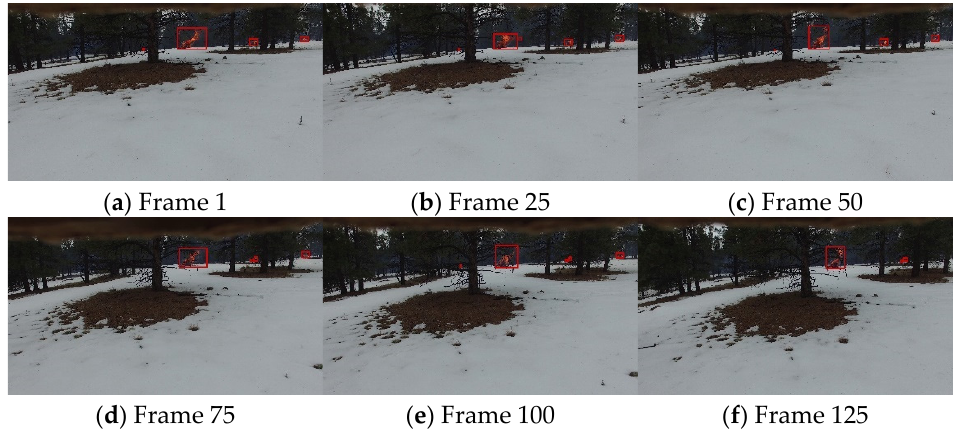
Figure 1. Schematic diagram of forest fi re detection in continuous video frames.